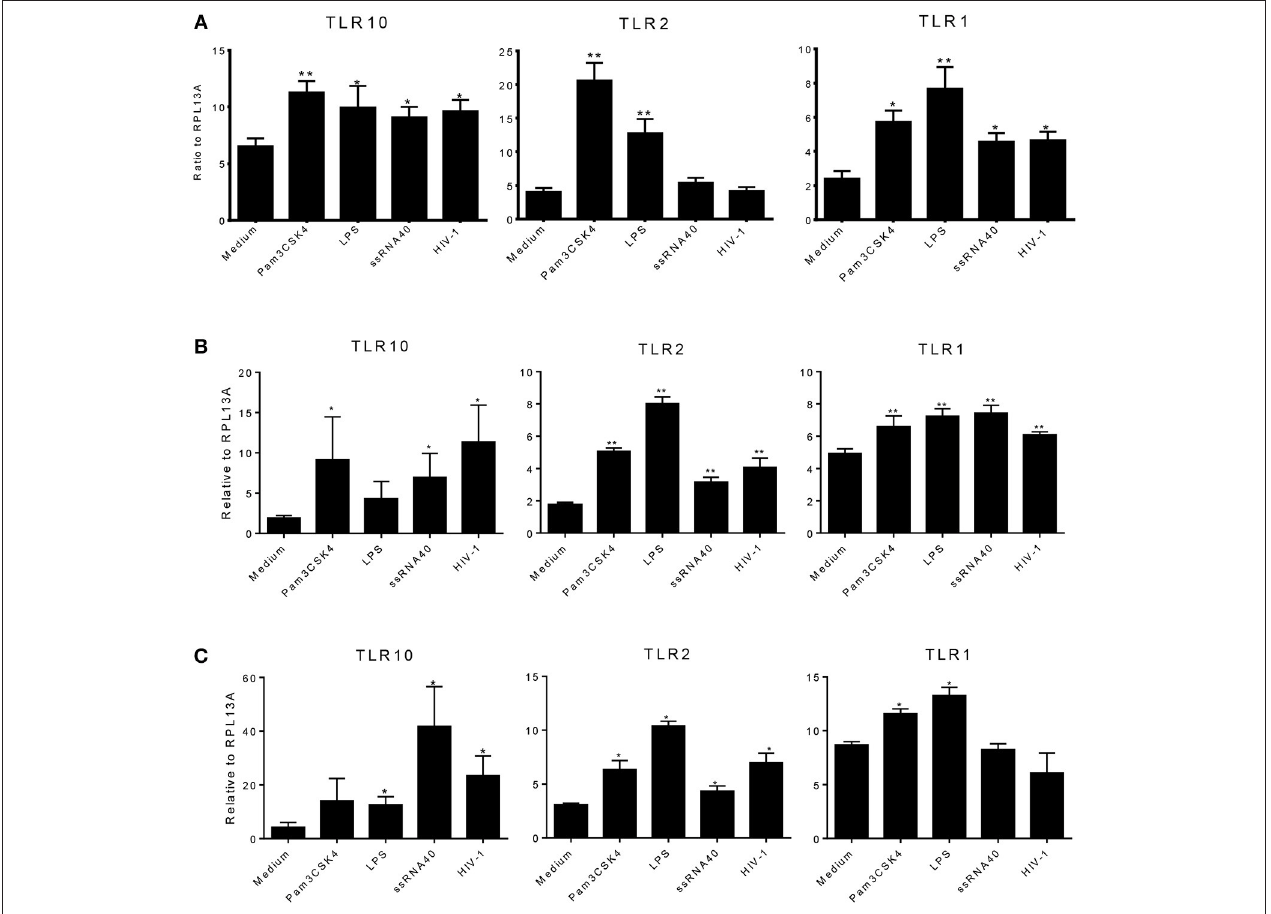
FIGURE 4 | Effects of PAMPs and HIV-1 on the level of TLR expression in cell cultures. (A) qRT-PCR of TLR10, TLR2, and TLR1 mRNA from MCF-10A cells treated with TLR2 PAMP Pam3CSK4, TLR4 PAMP LPS, TLR7/TLR8 PAMP ssRNA40, and cell-free HIV-1 BAL. (B) q-RT-PCR in THP-1 cells. (C) qRT-PCR in primary BM cells. Data set is representative of three different experiments completed in triplicate. Statistic marks: * p < 0.05 , ** p < 0.01 for the Mann-Whitney t -tests, each group compared to medium-treated group